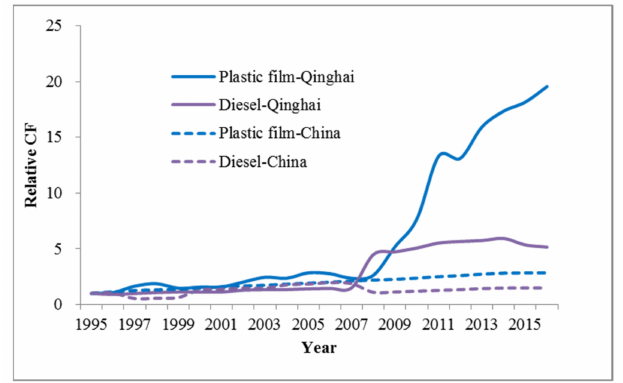
Figure 5. Changes in the relative CFs of plastic film and diesel in Qinghai province and